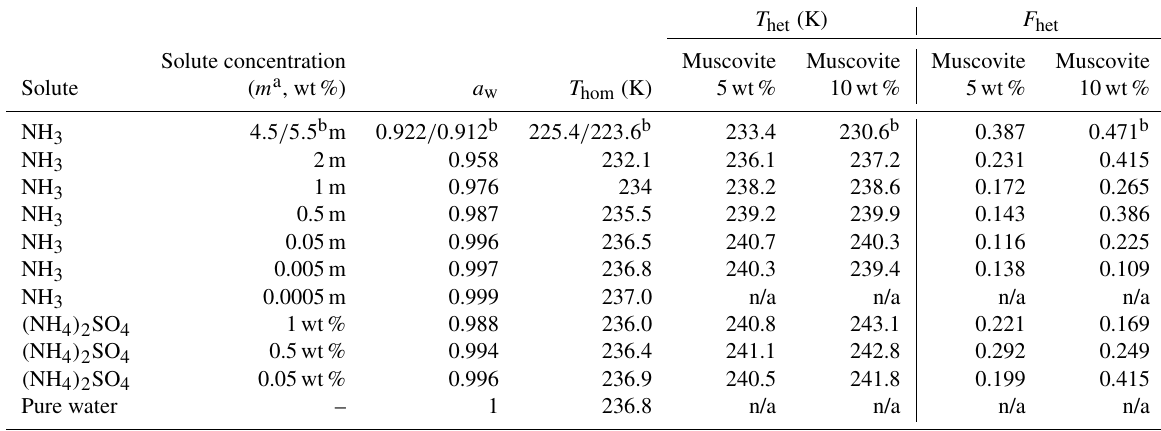
Table 1. Summary of the freezing experiments with emulsified aqueous solution droplets containing muscovite (5wt% and 10wt%). Note that the absolute uncertainty in F het may be up to ± 0.1. Only F het values above this threshold are clear evidence of heterogeneous IN.